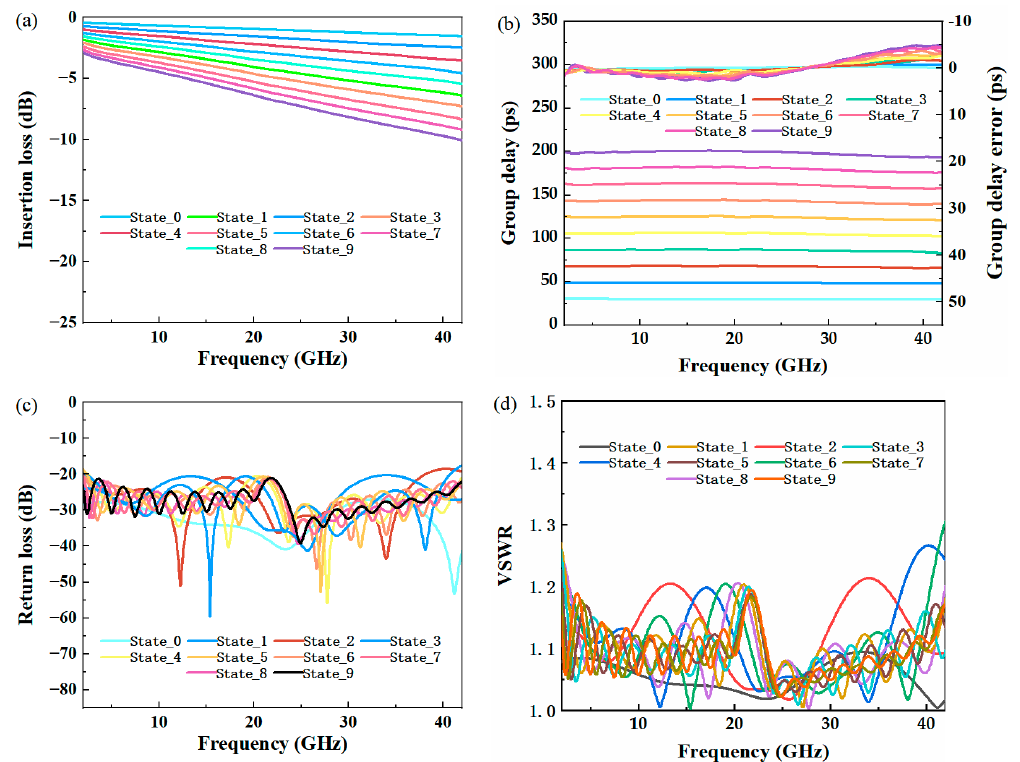
Figure 6. Simulated results of the TTDL network: ( a ) insertion loss, ( b ) group delay and group delay error, ( c ) return loss, and ( d ) VSWR.